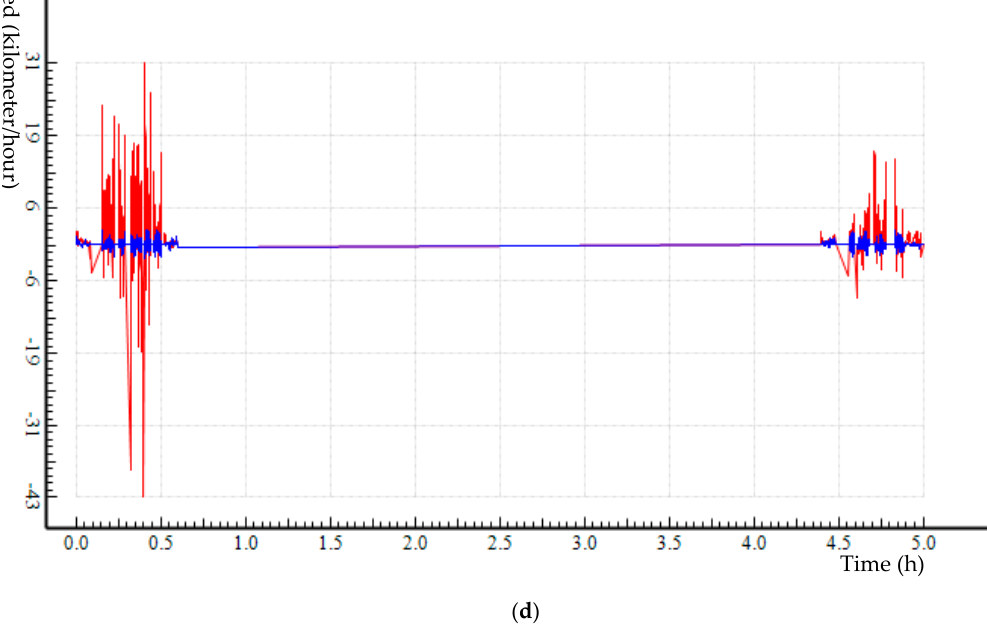
Figure 12. Speed loss in the post-simplification data of Trajectory 2 using DP and EDP algorithms with a distance threshold of: 1-m ( a ); 5-m ( b ); 10-m ( c ); and 25-m ( d ).